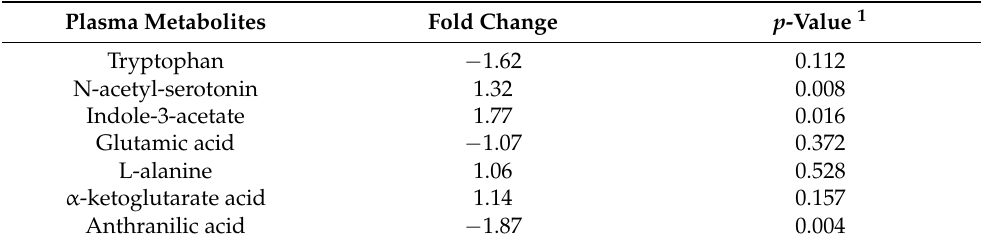
Table 3. Changes in tryptophan metabolites three months after